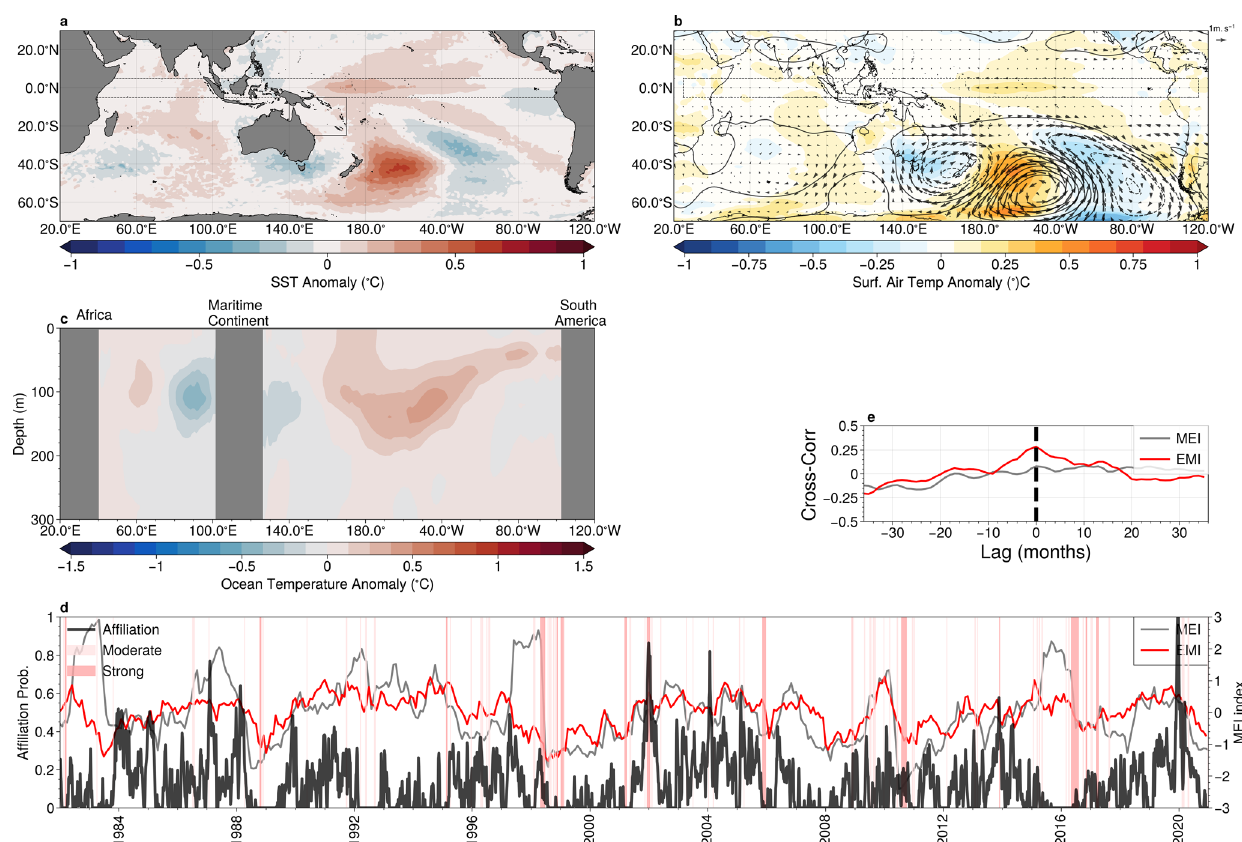
Fig. 9 | Teleconnections Associated with Marine Heat Waves in the Coral Sea and Great Barrier Reef. a Sea-surface temperature (SST) anomaly; b surface air temperature (colours) with anomalous mid-tropospheric (500hPa) geopotential height (contour lines, contour interval 5m) and winds (vectors); and c subsurface ocean temperatures (averaged latitudinaly between 5°S and 5°N within the region indicated by dashed lines in panels a and b ), associated with archetype #3; d The